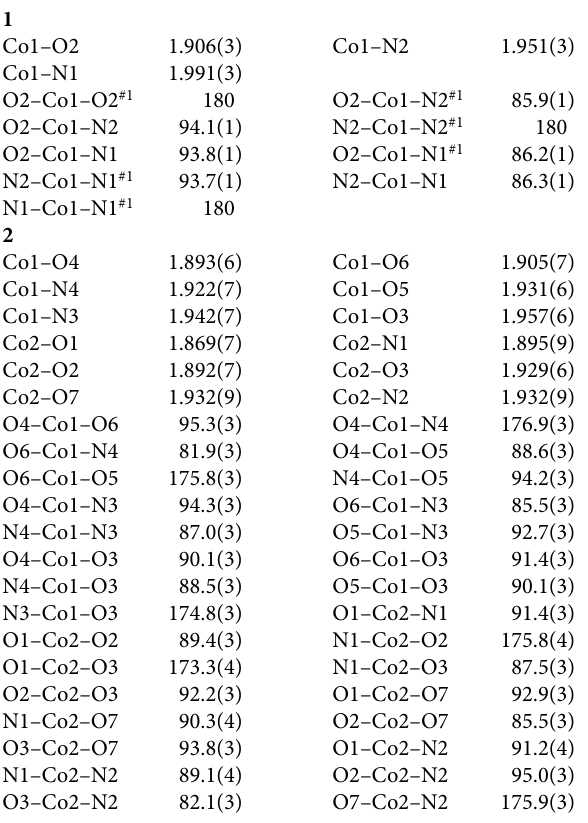
Table 2. Selected bond lengths (Å) and angles (°) for the